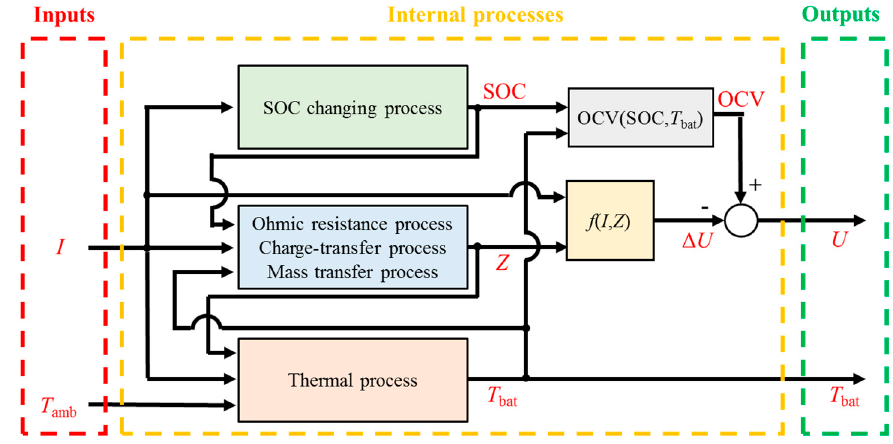
Figure 2. Inputs, outputs, and main internal processes of the battery ( T amb : ambient temperature).